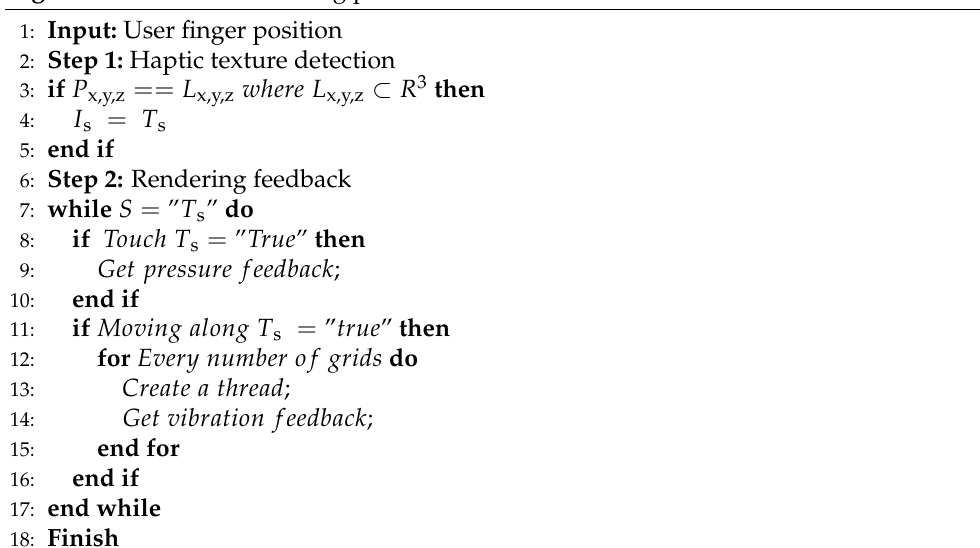
Algorithm 1 Texture-rendering